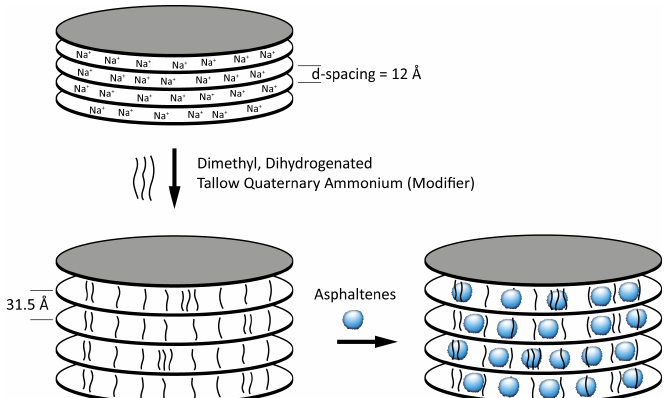
Figure 33. Asphaltene adsorption by Na + montmorillonite (MMT) nanoclays. Figure adapted from Ref. [153].